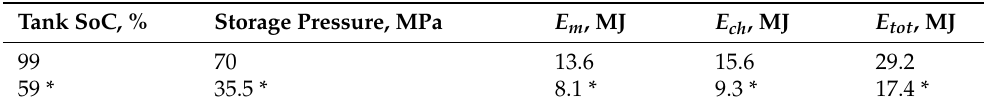
Table 1. Portions of mechanical and chemical energies contributing to the blast strength after 62.4 L tank rupture in a fire for two different SoC. Tank SoC,